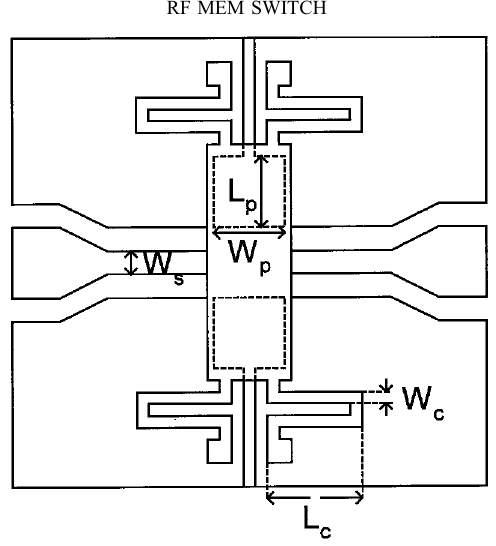
FIGURE 8 A schematic drawing that shows the dimension pecification of cantilever switches. W p and L p specify the dimension of bottom electrode pads, W s is the width of the center conductors of the CPW structure, W c is the width of the serpentine cantilever, and L c is the total length of the serpentine cantilever.